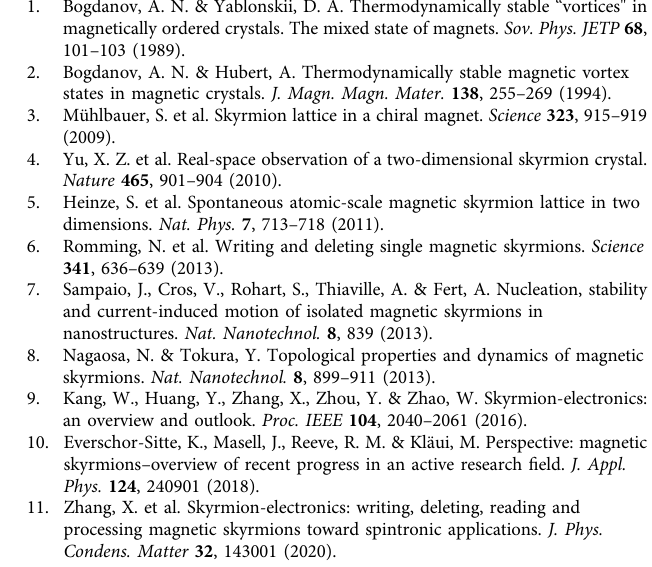
skyrmions and the upper rim. Additionally, the repulsive inter- actions with edge-skyrmions hinder center-skyrmions from hopping from one bit to another. It is anticipated that all sky- rmions, the ones that store the information and the ones that are used as bit separators, move coherently under lateral currents.